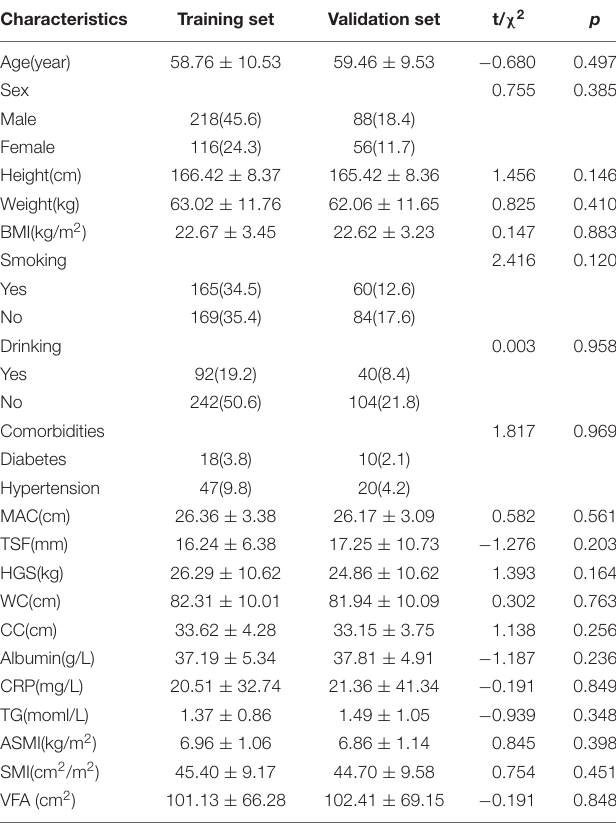
TABLE 1 | Basic characteristics of involved